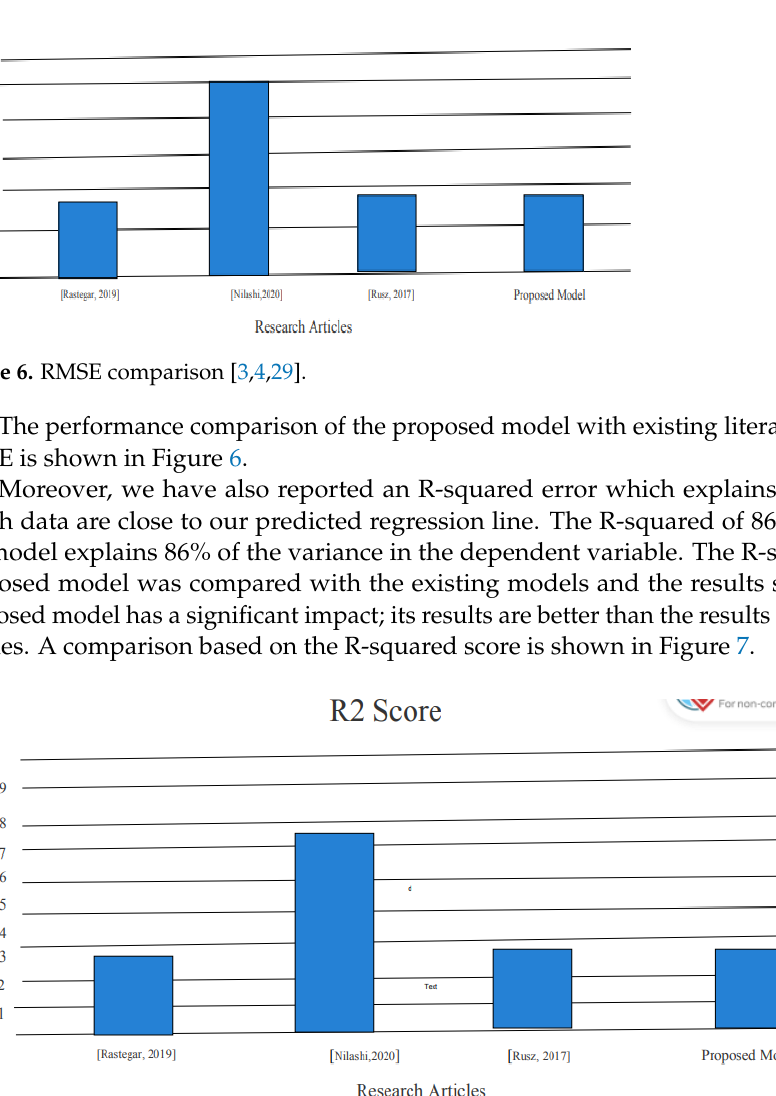
Figure 7. R-squared score comparison [3,4,29].